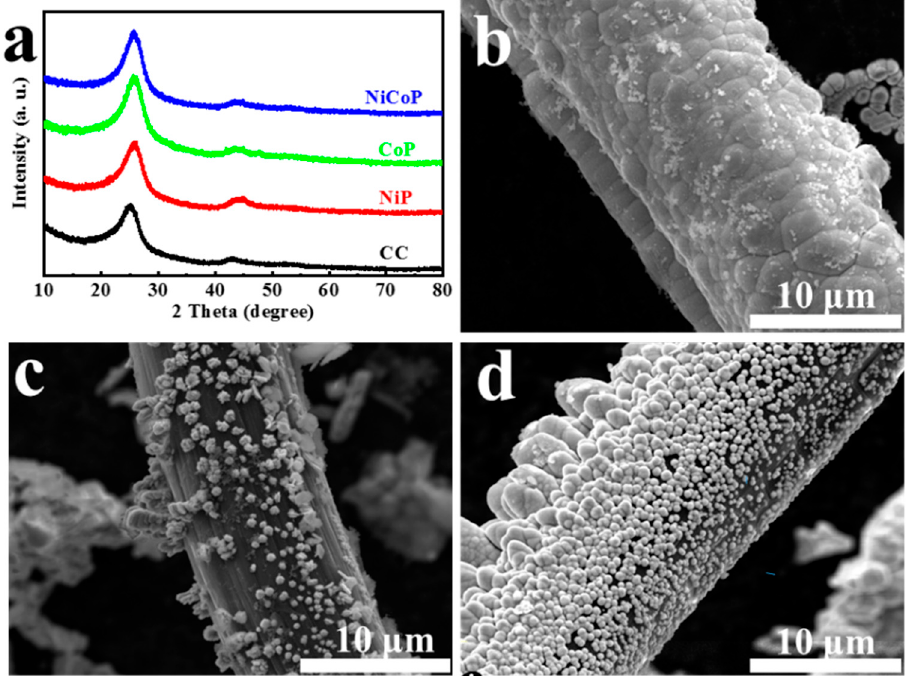
Figure 2. ( a ) XRD of CC, NiP, CoP, and NiCoP. SEM images of ( b ) NiP, ( c ) CoP, and ( d ) NiCoP. X-ray photoelectron spectroscopy (XPS) characterization was also carried out to further illustrate the species information and surface valence of each element in electrochemically deposited phosphating compounds. The survey spectra (Figure S4) of NiCoP showed the existence of Ni, Co, P, and O peaks. For the Ni 2p spectrum (Figure 3a), it can be fitted into six peaks. The peaks of 873.1 eV and 855.3 eV are attributed to Ni 2+ 2p 1/2 and Ni 2+ 2p 3/2 , respectively. Another pair of peak binding energies of 874.4 eV and 856.4 eV belong to Ni 3+ 2p 1/2 and Ni 3+ 2p 3/2 , respectively [28,29]. The final pair of diffraction peaks of 879.6 eV and 861.5 eV are assigned as satellite characteristic peaks of Ni 2p 1/2 and Ni 2p 3/2 components, respectively [29]. For the Co 2p spectrum (Figure 3b), there are four decoupled peaks. The binding energies of 780.9 eV and 796.5 eV are certified as Co 2p 3/2 and Co 2p 1/2 , respectively. Likewise, two shake-up satellite peaks are centered at 803.3 and 786.0 eV [23,30]. The existence of Ni 2+ and Co 2+ can accelerate electrolytic water reaction by weakening the O-H bond. Furthermore, the P 2p region (Figure 3c) consists of P-O (132.9 eV) and M-P (129.9 eV) bonds and the O 1s peak (Figure 3d) is centered at 531.2 eV, which suggests the coexistence of the metal phosphides and the oxide species on the NiCoP surface [25,31]. Therefore, the above results just confirm that one-step electrochemical deposition can obtain NiCoP, avoiding the tedious operation steps brought by high-temperature phosphating. A large number of works in the literature have suggested that positively charged Ni δ + /Co δ + and negatively charged P δ - active sites are formed in phosphating compounds, accelerating charge transfer and reducing internal resistance, and thus are favorable to HER and OER activity [28]. Regarding the NiP XPS spectrum (Figure S5), the Ni 2p spectrum can be fitted by the doublet characteristic of Ni 2+ (855.3 eV and 873.1 eV) and Ni 3+ (856.5 eV and 874.5 eV) as well as two shake-up satellites (861.6 eV and 879.7 eV). For the CoP sample, there are two shake-up satellite peaks (785.2 eV and 803.3 eV), Co 2p 1/2 (796.2 eV), and Co 2p 3/2 (780.2 eV) in the XPS spectrum of Co. In addition, the presence of P elements in both NiP and CoP XPS confirms the formation of mono-metal phosphates.